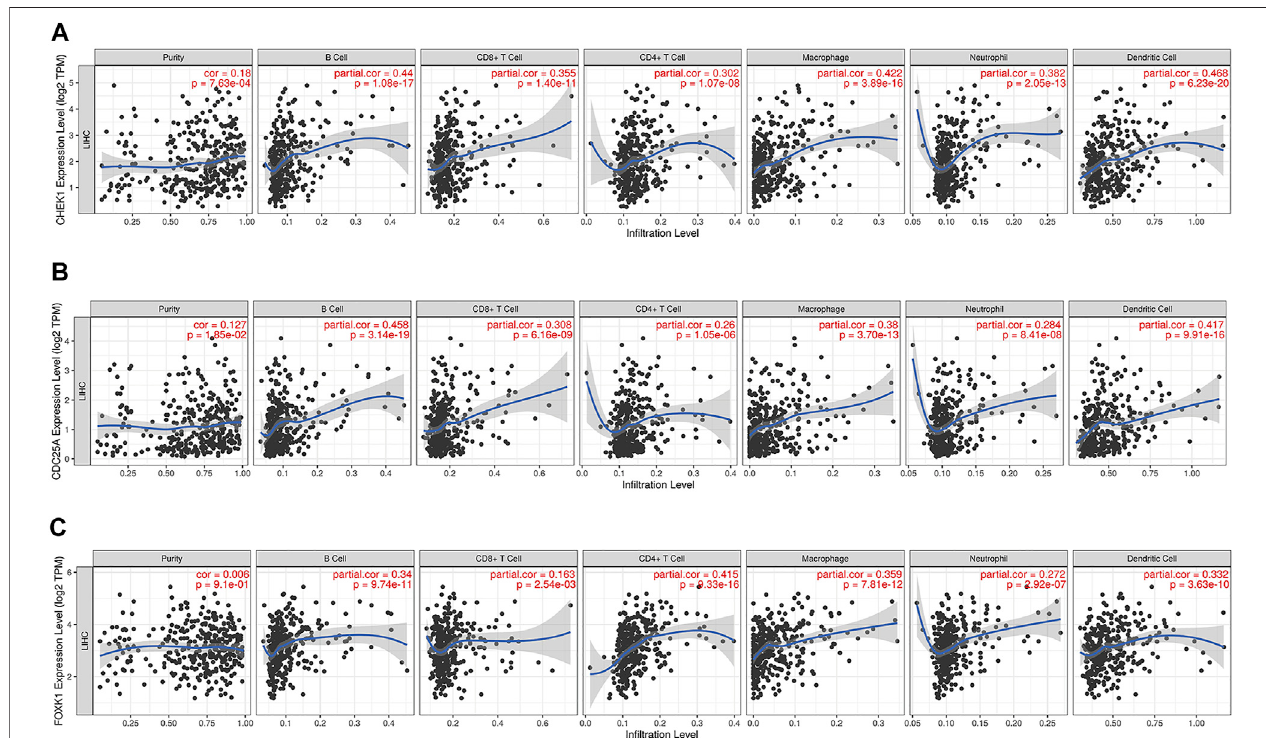
TABLE 4 | Analysis of the correlations between the expression of mRNAs in the ceRNA network and that of immune cell biomarkers. Immune cell Gene CHEK1 CDC25A FOXK1 Cor p Value Cor p Value Cor p Value B cell